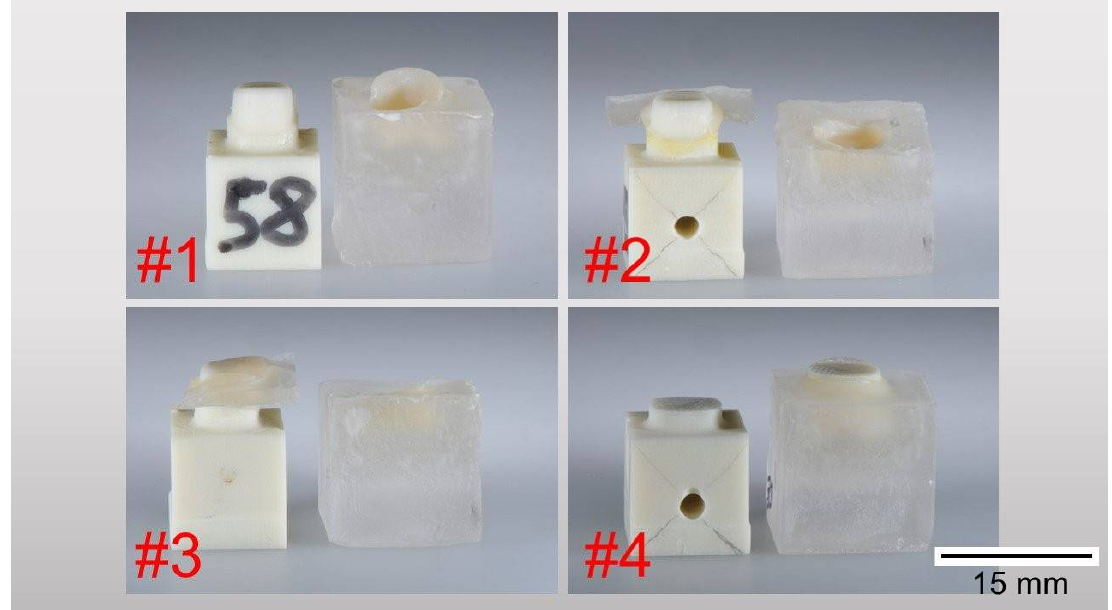
Figure 7. Illustration of the defined failure criteria: #1 “Complete debonding”, #2 “Partial debonding”, #3 “ Debonding of the occlusal crown surface”, #4 “Stump fractured”.